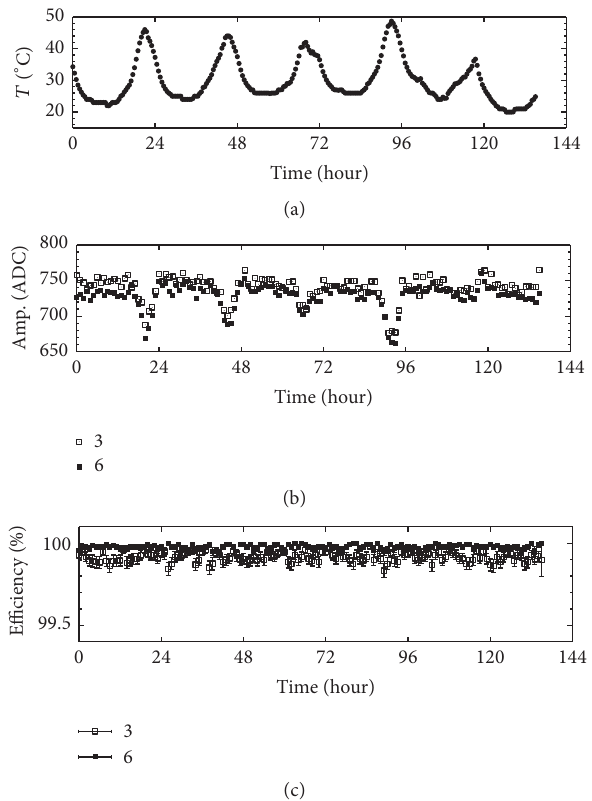
Figure 15: Time dependence of relevant operational parameters during 6 days of data taking in outdoor conditions. Temperature variations up to 25 ∘ C were sustained (a), with not more than 10% mean amplitude changes (due to partial compensation of the anode HV). The tracking efficiency was consistently high, shown in (c), during the whole period (note the scale on (c) starts at